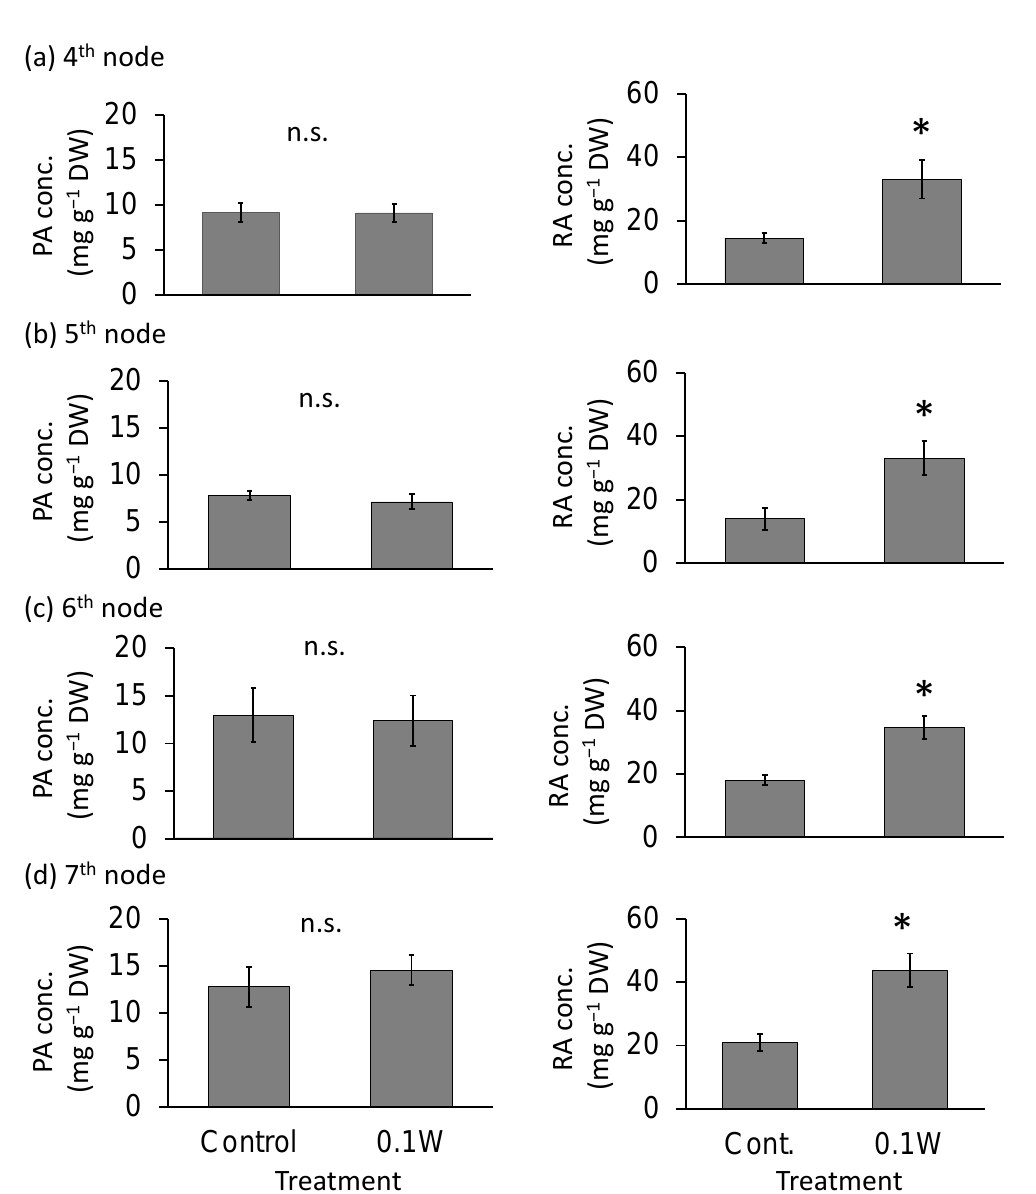
Figure 3. Effect of exposure to 6 h of nocturnal UV-B lighting on phytochemical (perillaldehyde (PA), rosmarinic acid (RA)) concentrations (per dry weight basis) (Experiment 1). Perilla plants were irradiated for 6 h from 23:00 to 05:00 h in all UV-B light treatments. UV-B radiation intensity at the top of the plant canopy was set to 0.1 W m − 2 . The integrated UV-B energy at 0.1 W m − 2 was 2.2 kJ m − 2 day − 1 . Leaves at the 4th node counted from the bottom of the main stem were harvested 1 week after treatment initiation; thereafter, leaves at the 5th, 6th, and 7th nodes were sampled from the same plants at 2, 3, and 4 weeks after treatment initiation. Vertical bars indicate SE ( n = 6). The asterisk symbol indicates significant difference between treatments at p < 0.05, and n.s. indicates no significant difference as per the t